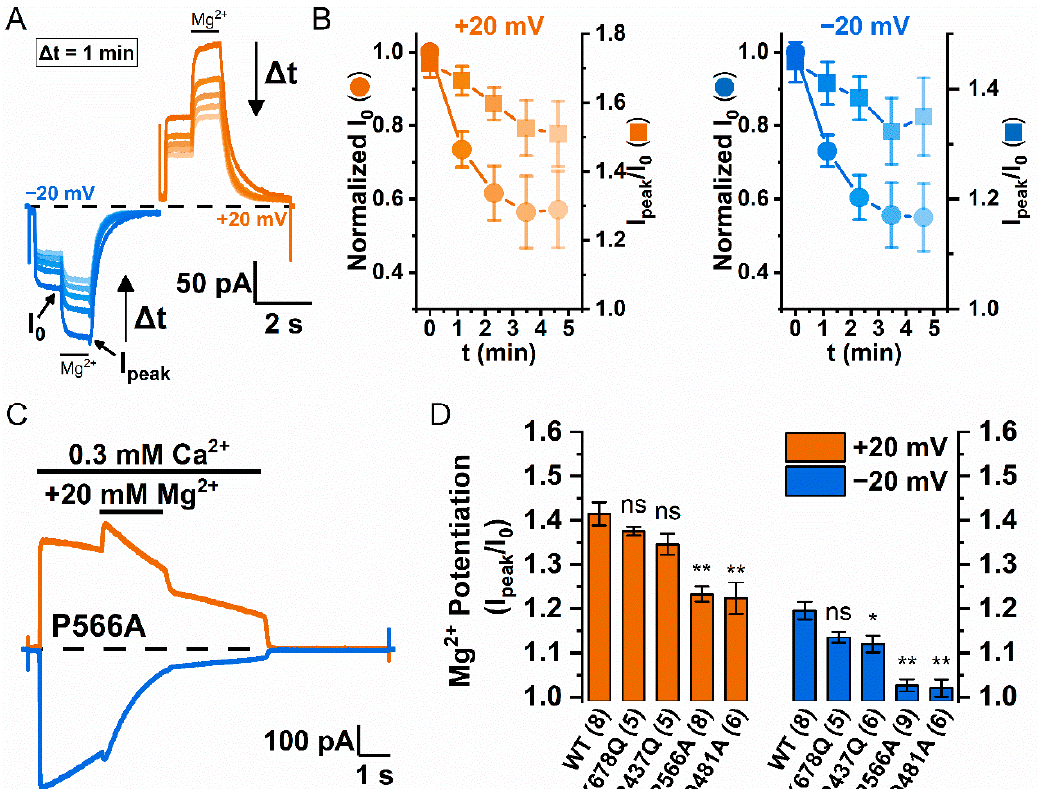
Figure 4. Involvement of Phospholipids in divalent cation-induced potentiation. ( A ) Representative recording traces are depicted to illustrate the decrease in Mg 2+ potentiation of Y589A 16A after channel rundown. For every minute, current was elicited with 100 µM Ca 2+ (a concentration chosen for reducing the speed of rundown), and 20 mM Mg 2+ were applied subsequently for 1 s (black bar above traces). ( B ) Reduction of Mg 2+ potentiation (I peak /I 0 ) over time at +20 mV (left panel, orange) and − 20 mV (right panel, blue) ( n = 6–9). The rundown of the control current (I 0 normalized to the I 0 of the trace at t = 0 min) is shown by circles, whereas the reduction of the Mg 2+ potentiation is shown by squares. ( C ) Mg 2+ potentiation of a PIP2 binding-site mutant P566A 16A at ±20 mV. The P566A 16A current was easier to run down and the degree of potentiation was also smaller compared to that in WT 16A . ( D ) Comparing Mg 2+ potentiation at ±20 mV between WT 16A (replotted from Figure 1) and four mutants (numbers below each column are the number of patches). ns p > 0.05; * p < 0.05; and ** p < 0.005 by one-way ANOVA followed by Bonferroni’s multiple compar- isons.